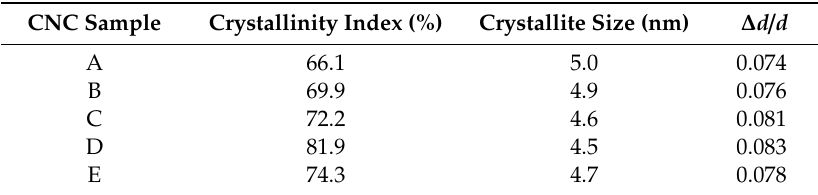
Table 5. Crystallographic parameters of